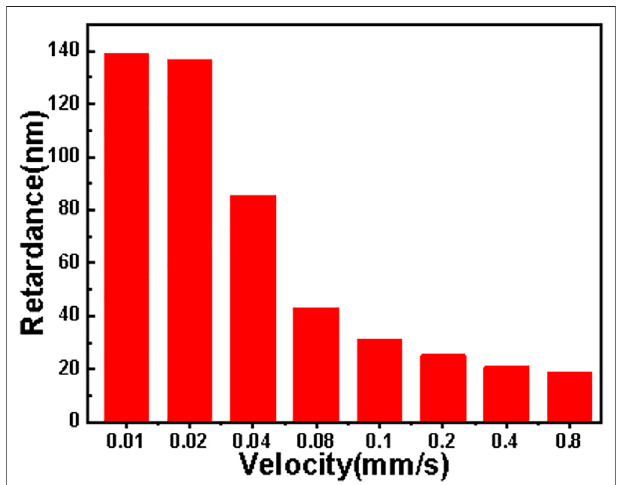
FIGURE 7 | Variation of the retardance with the scanning speed.